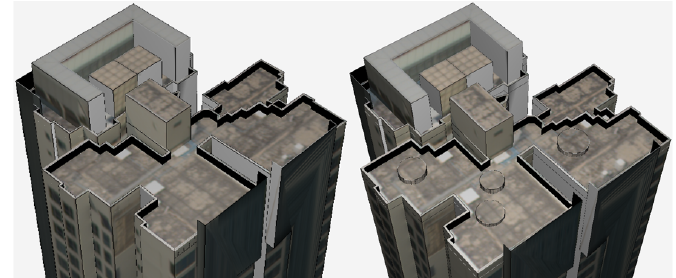
Figure 17. Adding roof infrastructure for building models by